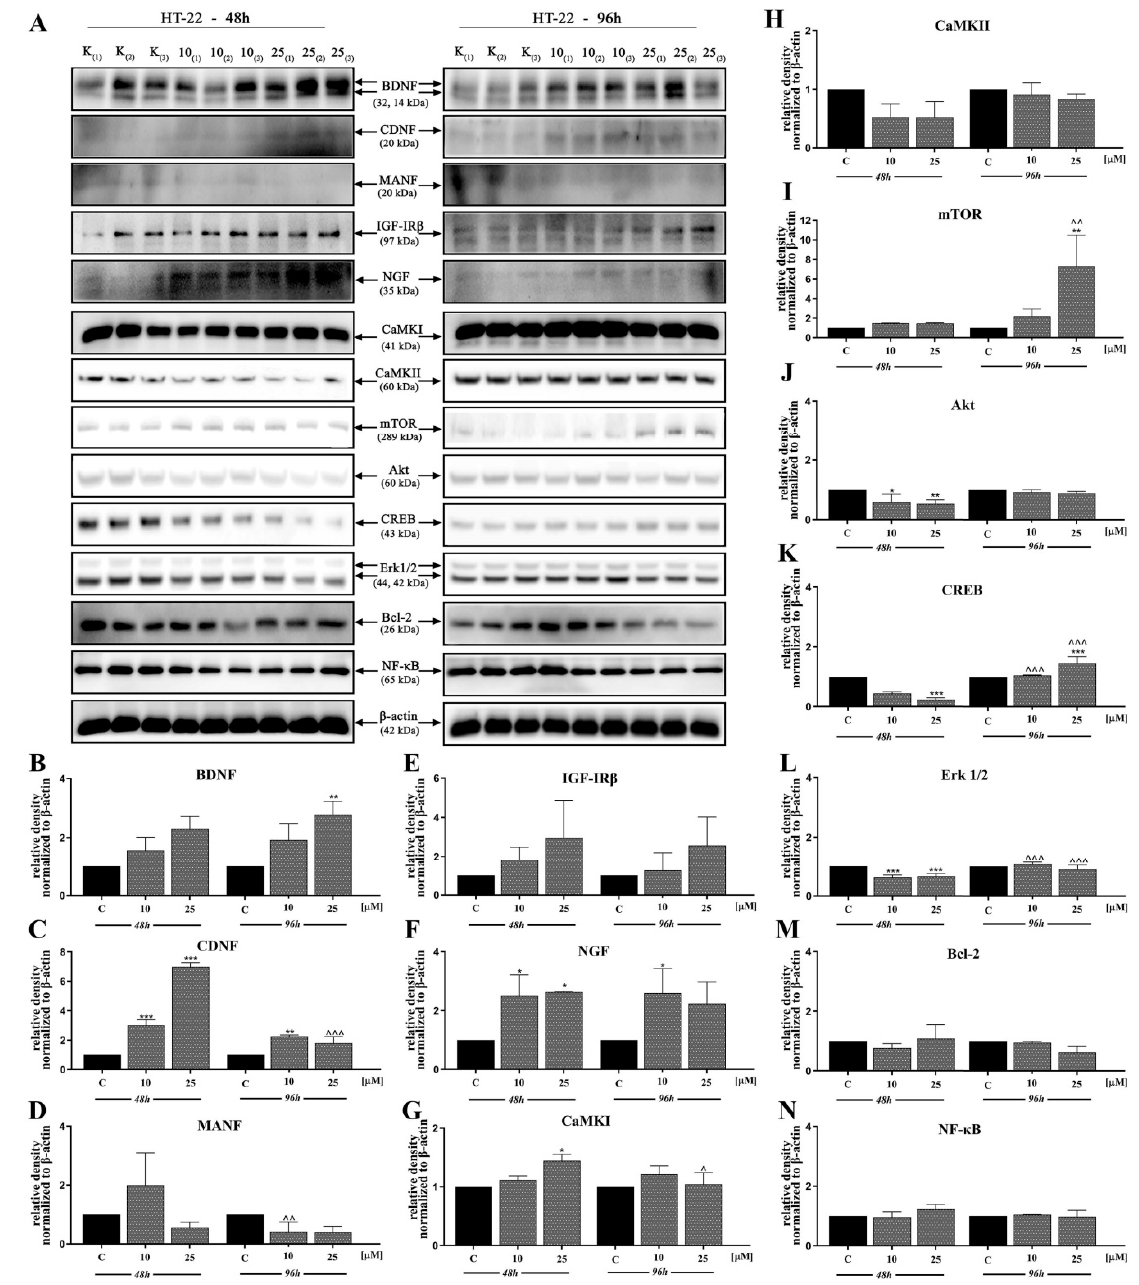
Figure 4. D2AAK1-mediated effect on HT-22 cellular protein pathways. Cells were treated for 48 and 96 h with two different concentrations of D2AAK1; representative immunoblots are shown ( A ). Western blot analysis of BDNF ( B ), CDNF ( C ), MANF ( D ), IGF- Ir β ( E ), NGF ( F ), CaMKI ( G ), CaMKII ( H ), mTOR ( I ), Akt ( J ), CREB ( K ), Erk 1/2 ( L ), Bcl-2 ( M ), NF- κ B ( N ) synthesis level was performed. Bars indicate SD, n = 3, * p < 0.05; ** p < 0.01; *** p < 0.001 when compared between the control sample, not treated with the compound and the test sample incubated with the D2AAK1; ^ p < 0.05; ^^ p < 0.01; ^^^ p < 0.001 when compared between the incubation time (48 and 96 h).